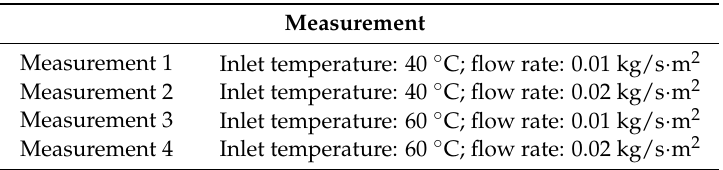
Figure 2. Collector performance testing equipment. Table 2. Measurement conditions.